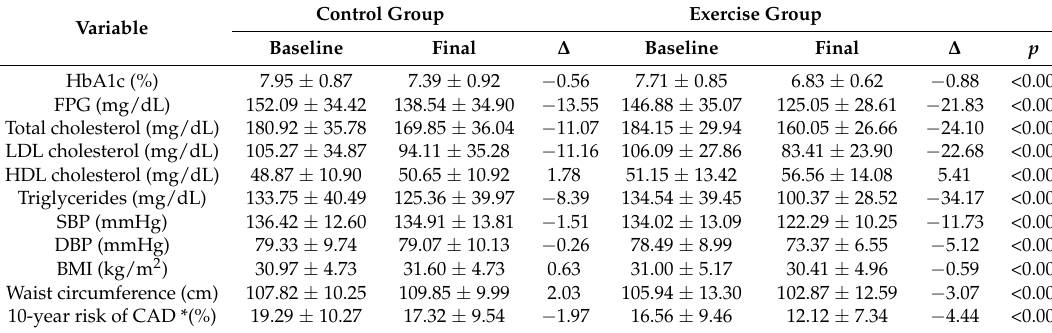
Table 2. Average values ( ± standard deviation) of the studied variables in the two evaluation points in both the intervention and control